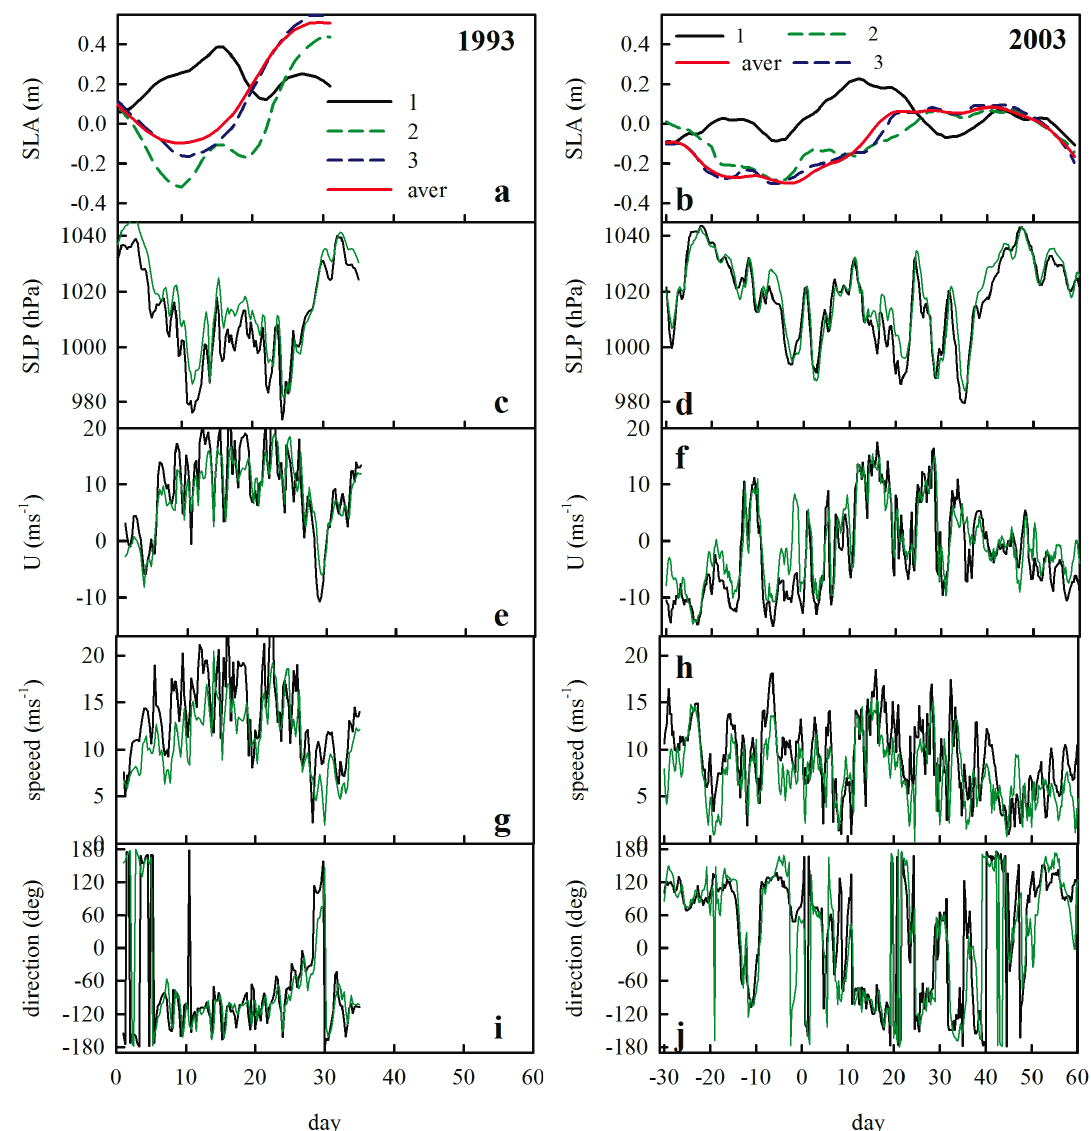
Figure 5. Time series of (a, b) SLA at pixels 1–3 and SLA averaged over the area indicated in Figure 1. (c, d) Sea level pressure (SLP) at locations 1 and 2. (e, f) U component of wind at locations 1 and 2. (g, h) Wind speed at locations 1 and 2. (i, j) Wind direction at locations 1 and 2. Data are presented for MBIs in 1993 and 2003 in the column on the left and right side, respectively.